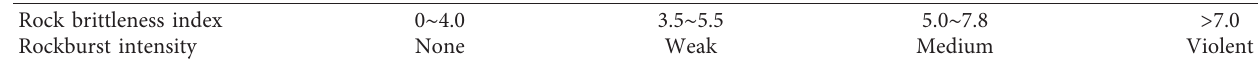
Figure 7: The relationship of ρ ∗ and ( E / E Table 5: The relationship between rock brittleness index and rockburst intensity [61].